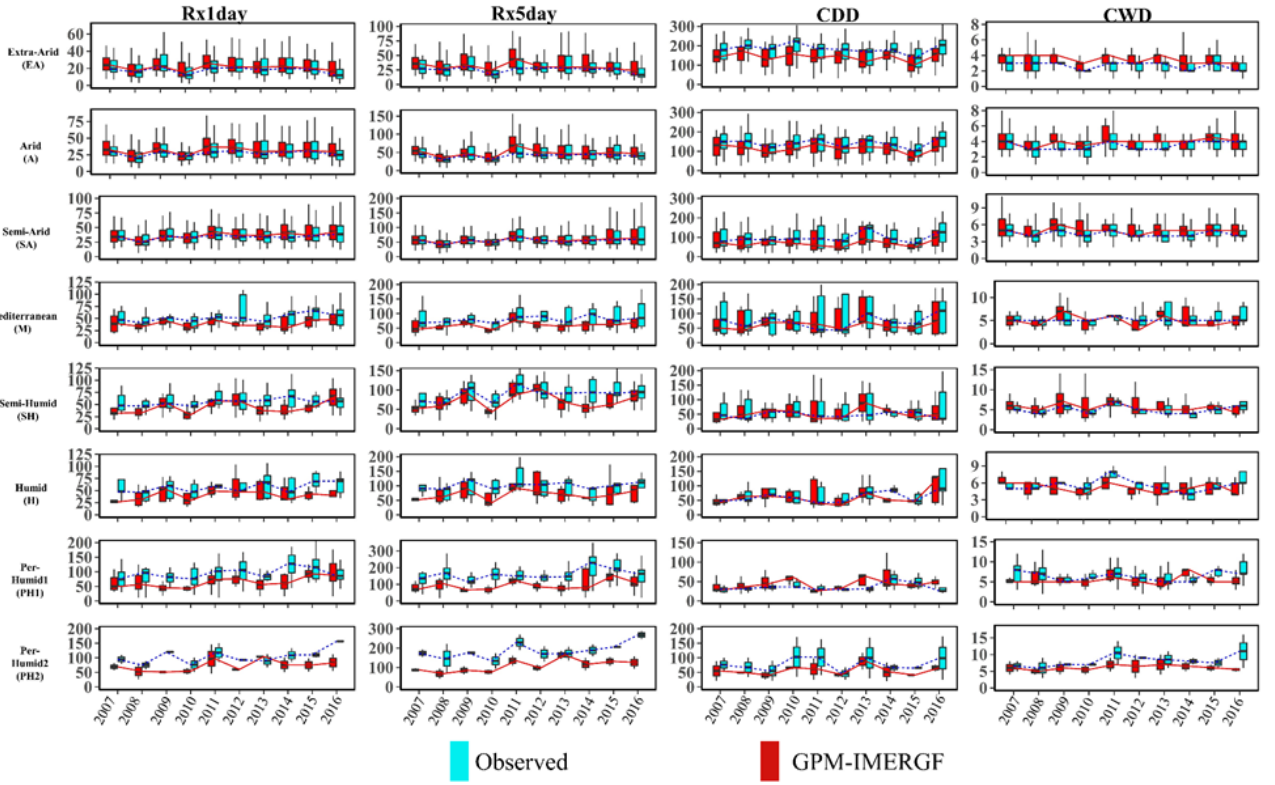
Figure 3. Temporal behavior of GPM-IMERGF in capturing maximum precipitation indices beside corresponding indices based on synoptic stations throughout 2007 to 2016.